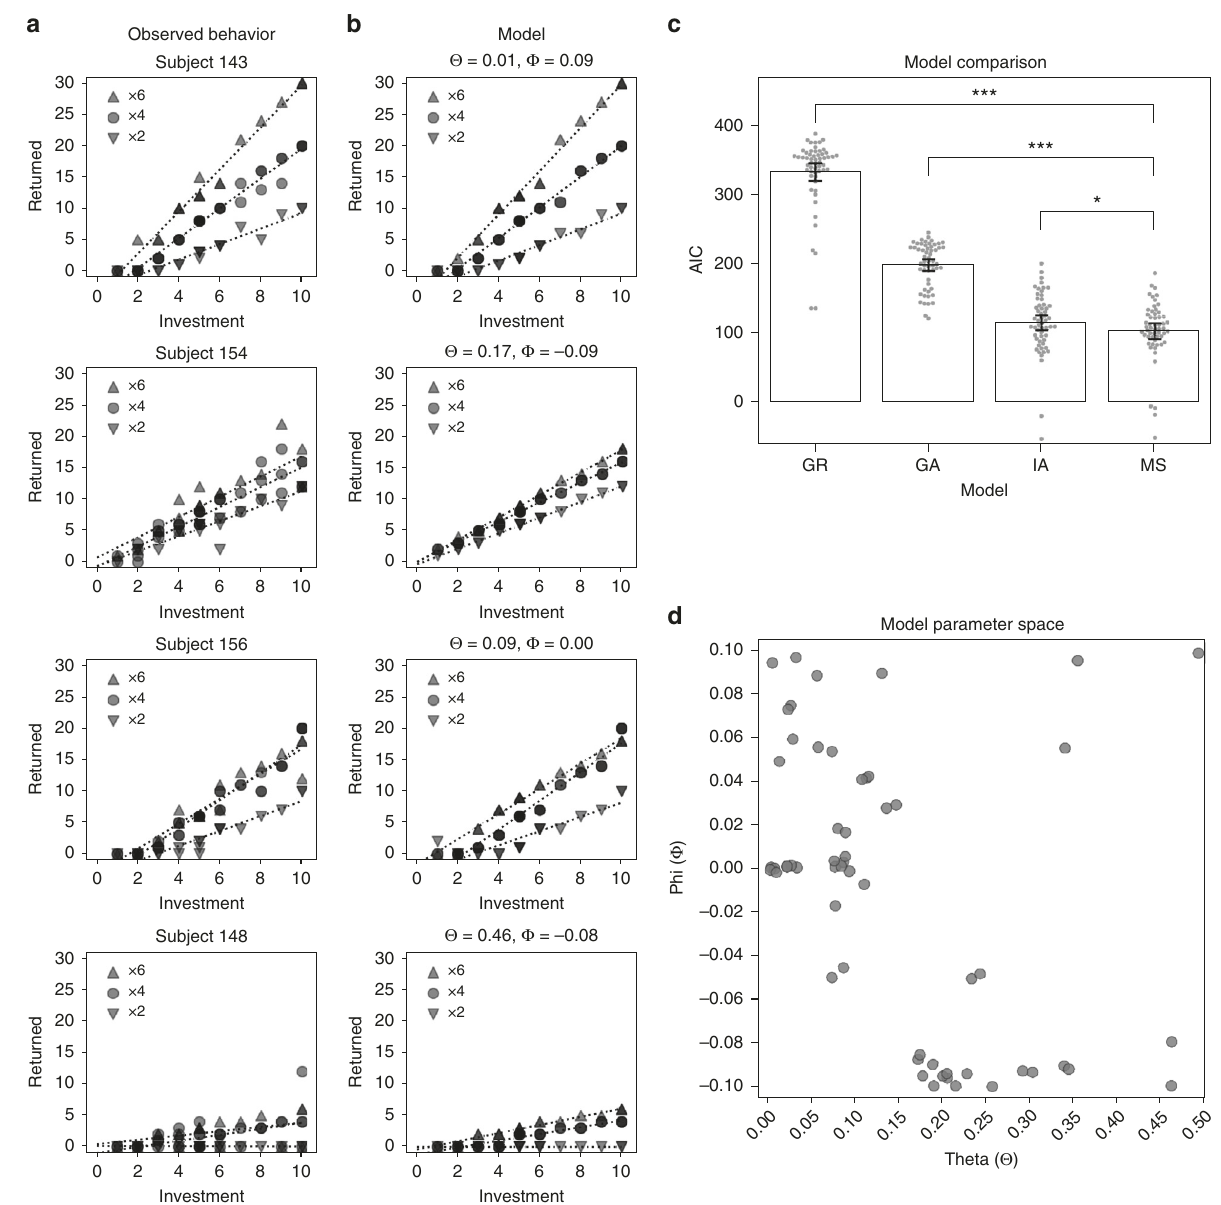
Fig. 2 Between-subject strategy variety in the Hidden Multiplier Trust Game. a Observed behavior of four example participants, displaying different moral strategies (top to bottom: inequity aversion — 143, guilt aversion — 154, moral opportunism — 156, greed — 148). Data points are semi-transparent: darker points represent multiple observations. Dotted lines are regression lines per multiplier condition. b At different parametrizations, the computational model captures the strategy variety observed in a , c Model comparisons. Moral Strategy (MS) Model best fi ts the observed behavior. AIC Akaike Information Criterion, GR greed, GA guilt aversion, IA inequity aversion, MS Moral Strategy Model. *** p < 0.001; * p < 0.05; p -values from non-parametric paired- sample permutation tests. Error bars represent bootstrapped 95% con fi dence intervals. d Two-dimensional continuous parameter space of the Moral Strategy Model, with the participants scattered by best- fi tting model